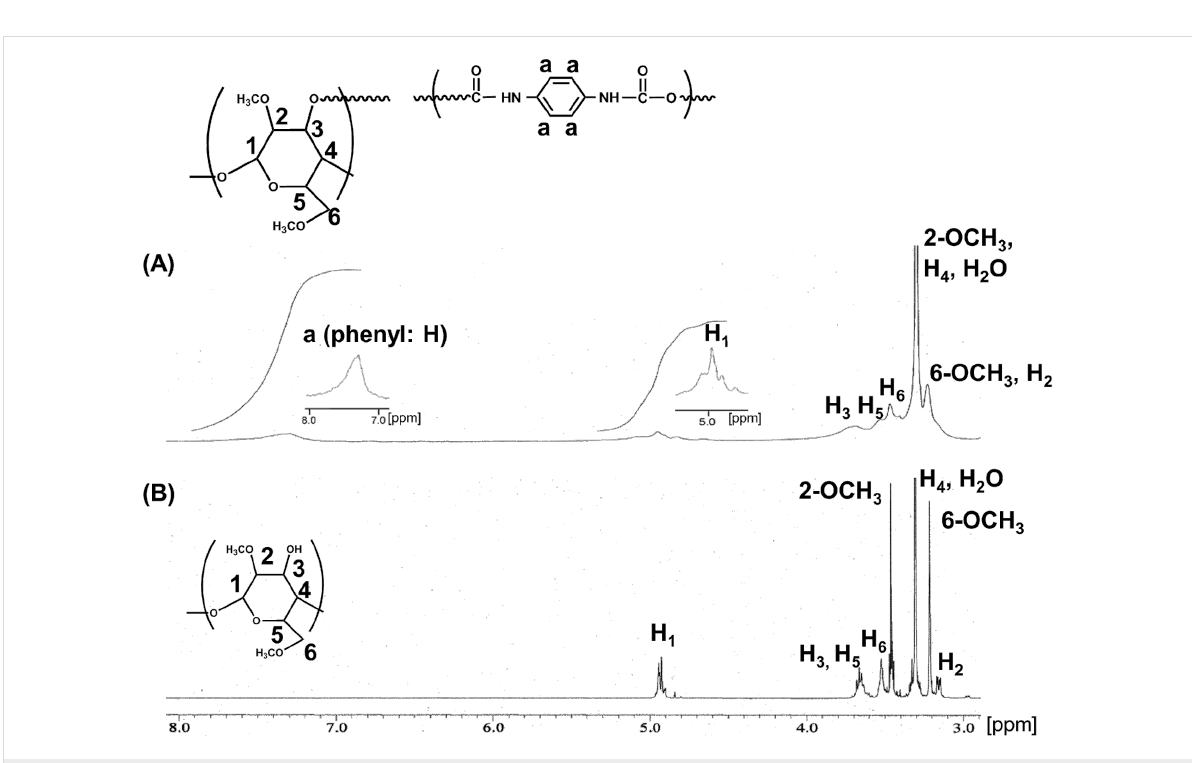
Figure 2: 1 H NMR spectra of (A) DM- β -CD/PDI polymer and (B) DM- β -CD in (CD 3 ) 2 SO.